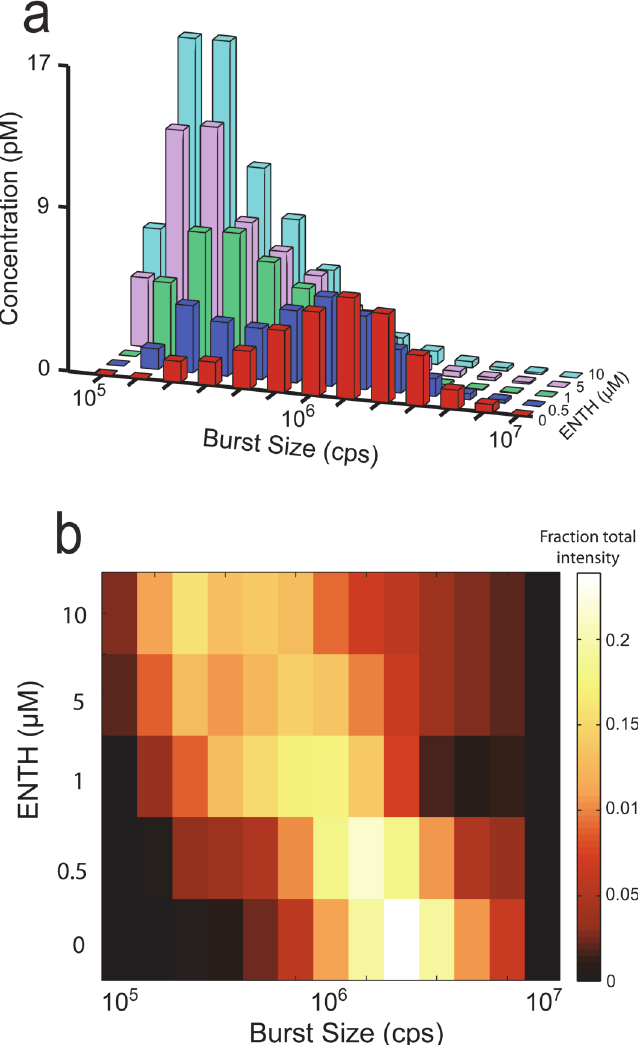
with 500 nM ( blue ), 1 μ M ( green ), 5 μ M ( purple ), and 10 μ M ( cyan ) ENTH. (b) Heat-map representation of the fractional intensity for each reaction shown in (a). The data shown is representative of three experimental